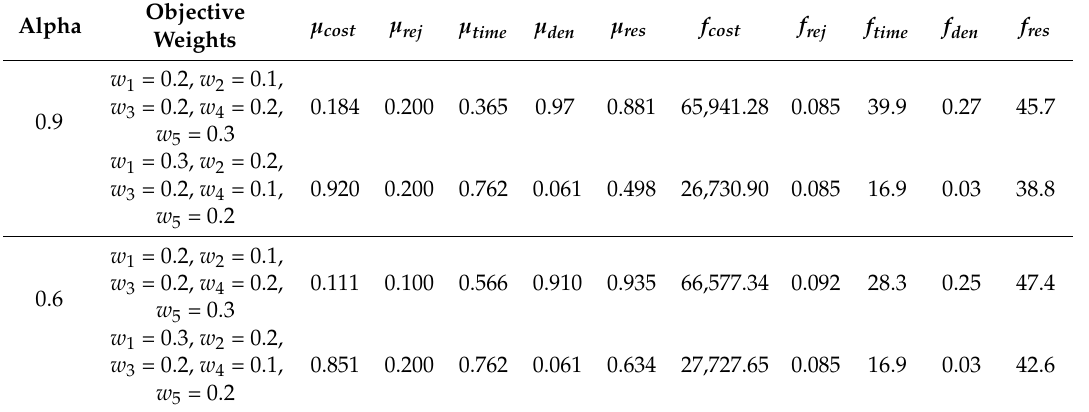
Table 7. Sensitivity analysis of the weighted additive approach.